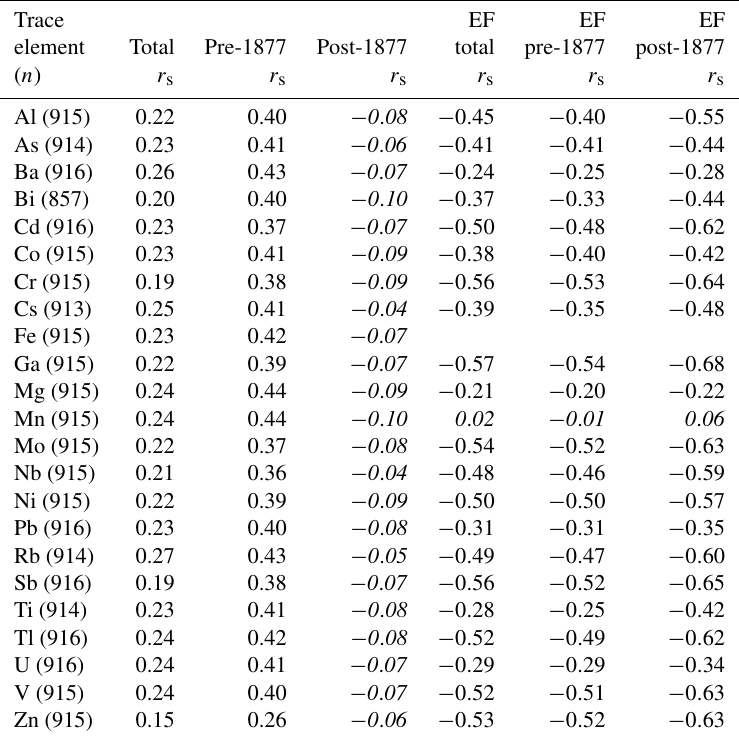
Table 1. The Spearman correlation coefficient ( r s , α = 0 . 01) for trace elements and the trace element enrichment factor (EF) relative to rBC concentration throughout the Dasuopu ice core. Italics indicate a non-statistically significant r s .